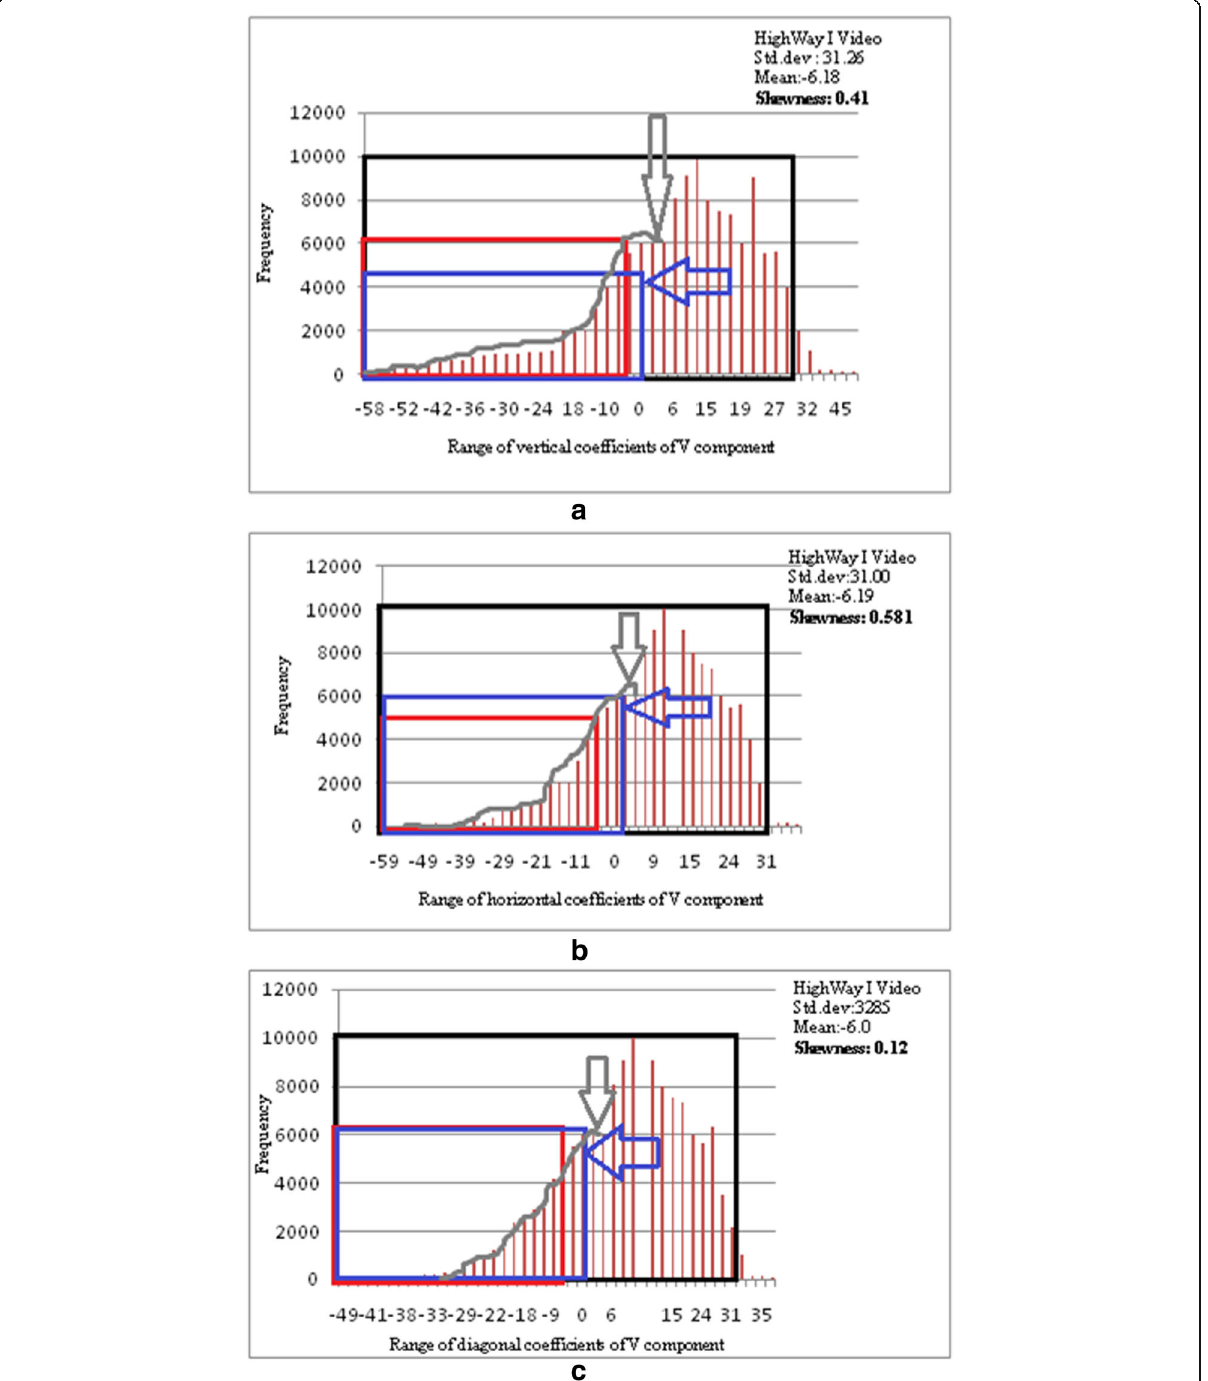
Fig. 4 Plot of a vertical, b horizontal and c diagonal wavelet coefficients of frame no. 100 from Highway I video sequence: The grey colour line shows the original shadow pixels, and the arrow mark in grey colour indicates the end of the shadow points. The blue colour square indicates the detected shadow pixels using skewness, and the arrow mark in blue colour indicates the end of the shadow points. The black and red squares indicate the detected shadow pixels using standard deviation [26] ( σ ) and relative standard deviation [27] ( σ / μ